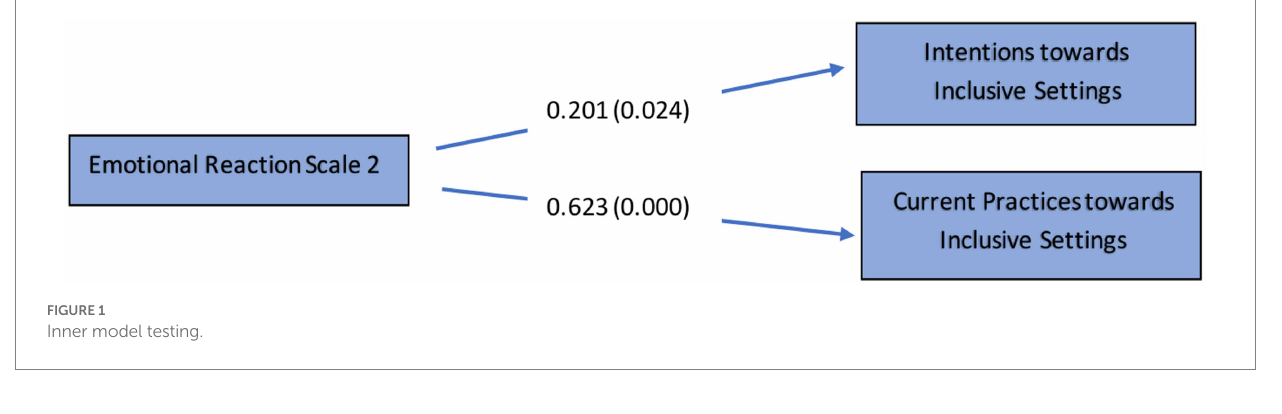
FIGURE 1 Inner model